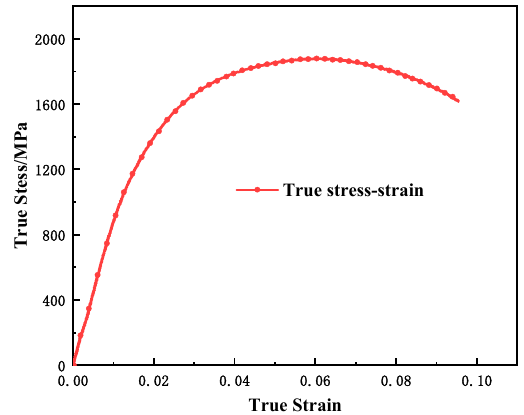
Figure 2. Static smooth tensile test results (0.001 s − 1 ).